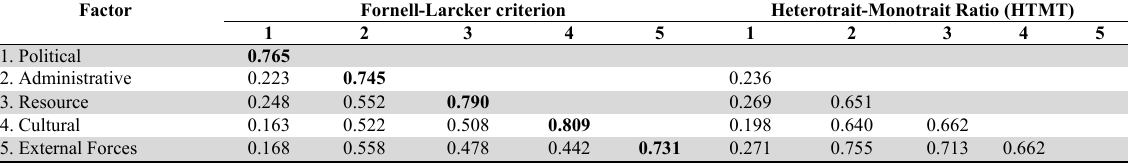
Discriminant Validity (Square root of AVEs in bold-diagonal) Factor Fornell-Larcker